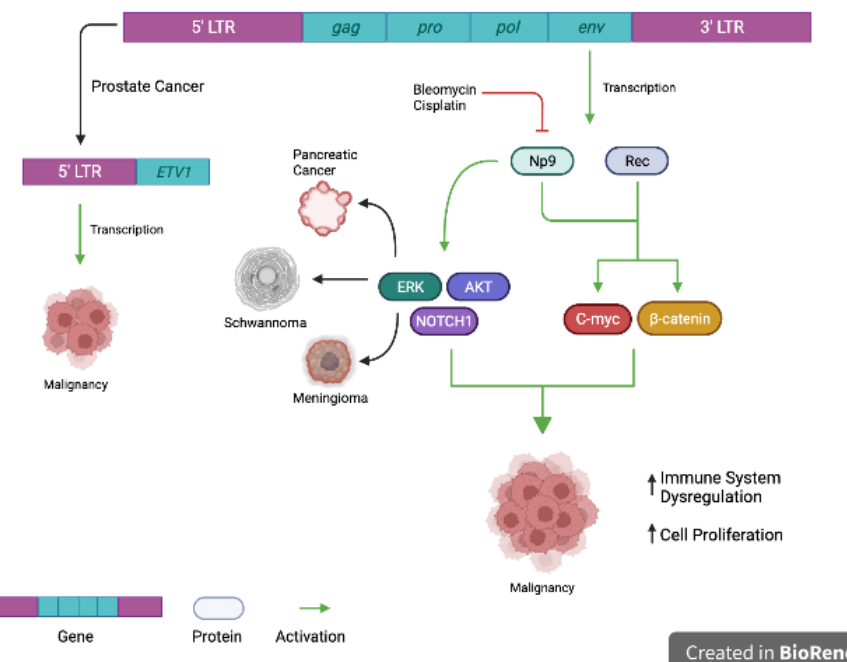
Figure 1. Examples of proposed mechanisms of HERV-K (HML2) oncogenesis. In prostate cancer, the 5′ long terminal repeat (LTR) may be fused to the ETV1 oncogene. Transcription of this gene may lead to impaired cell cycle regulation and malignancy. Similarly, transcription of HERV-K (HML2) env protein may lead to upregulation of Rec and Np9 proteins, which have been shown to be oncogenic drivers of disease. Through various downstream signaling pathways, they may increase immune system dysregulation and cell cycle proliferation, promoting oncogenesis. Figure 1 was made with Biorender.com (accessed on 29 June